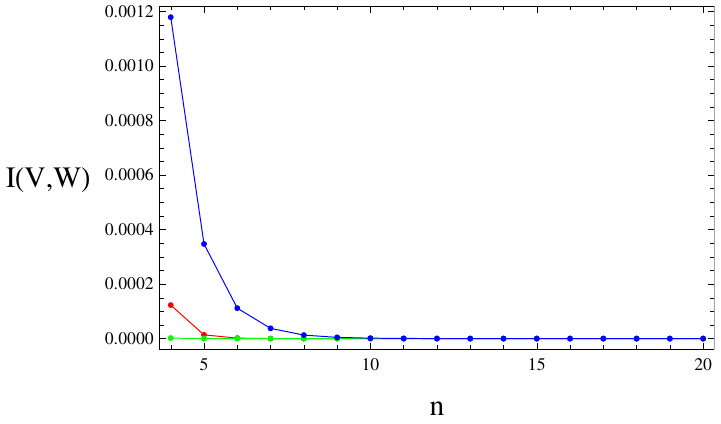
Figure 25 . The mutual information of gauge (cid:12)elds coupling with matter between two squares of equal sizes separated by a distance equal to the square size for algebra B (cid:25) center with m = 1 line), m = 1 (red line) and m = 2 (green